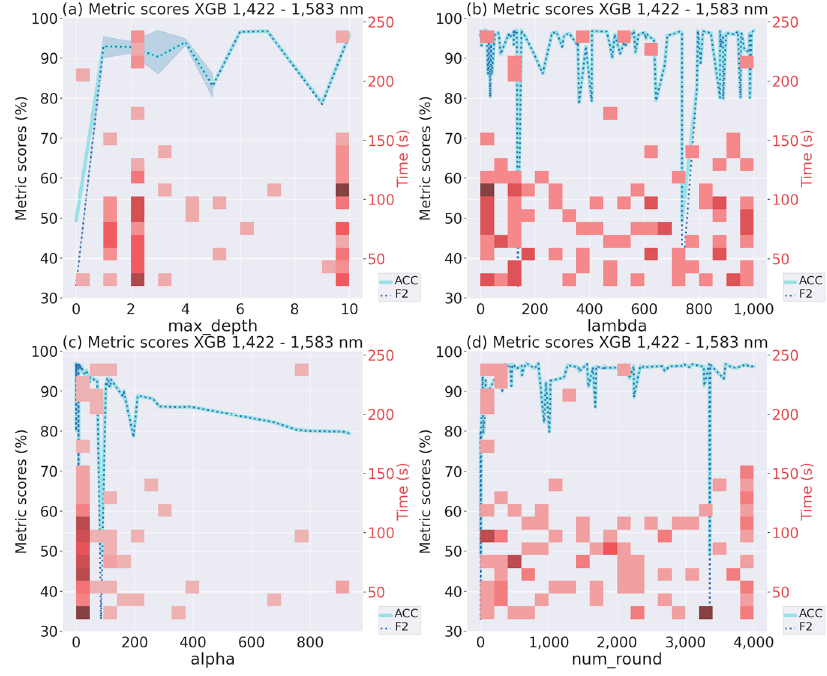
Figure 6. Hyperparameters of the best XGBoost model in the 1422–1583 nm wavelength range.